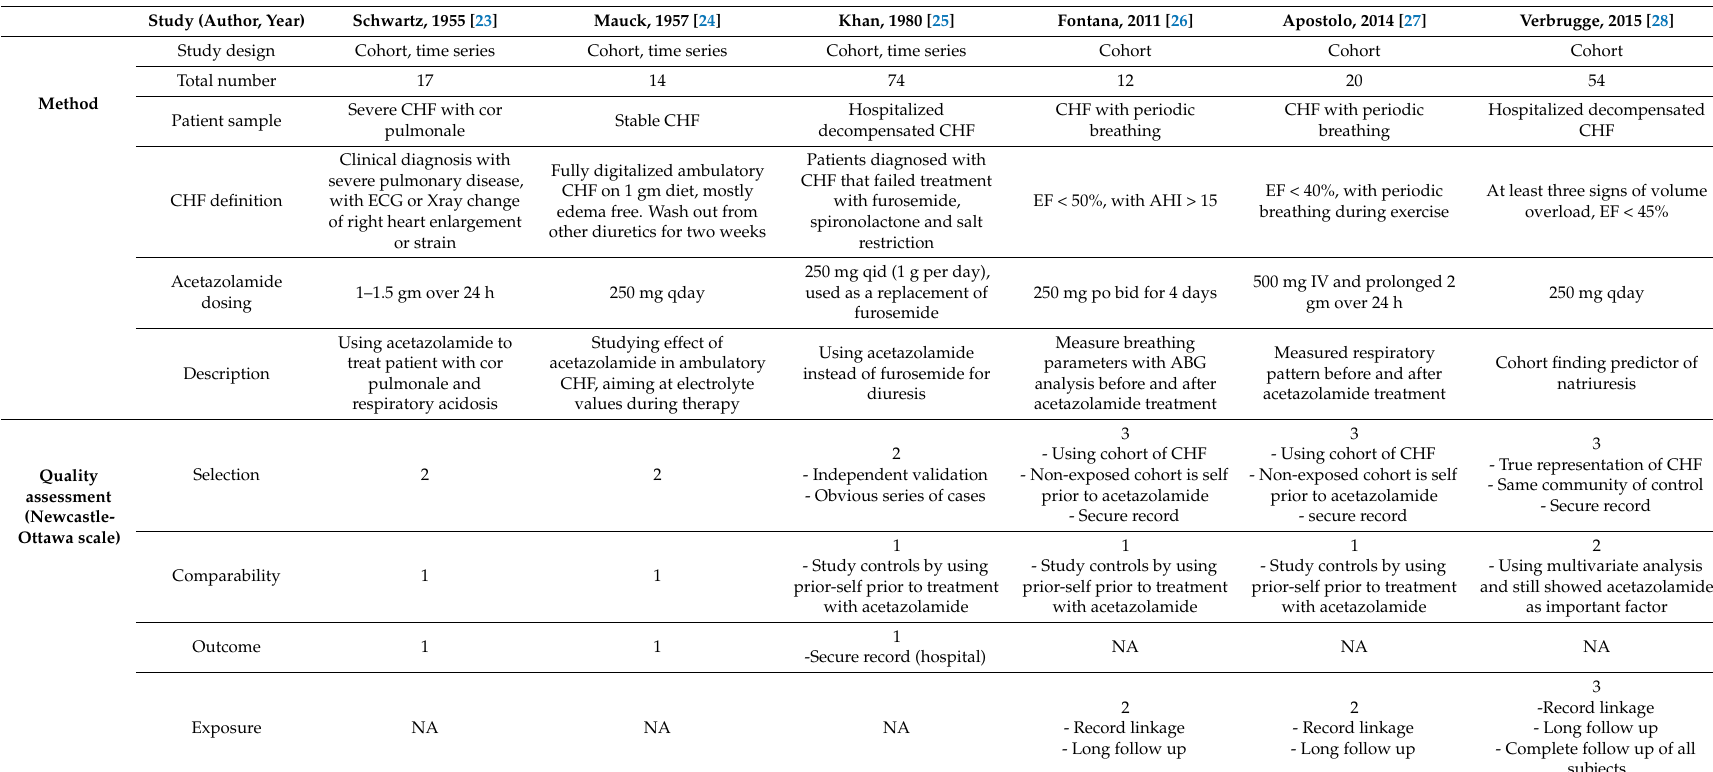
Table 2. Main characteristics of cohort studies included in meta-analysis of acetazolamide therapy in heart failure